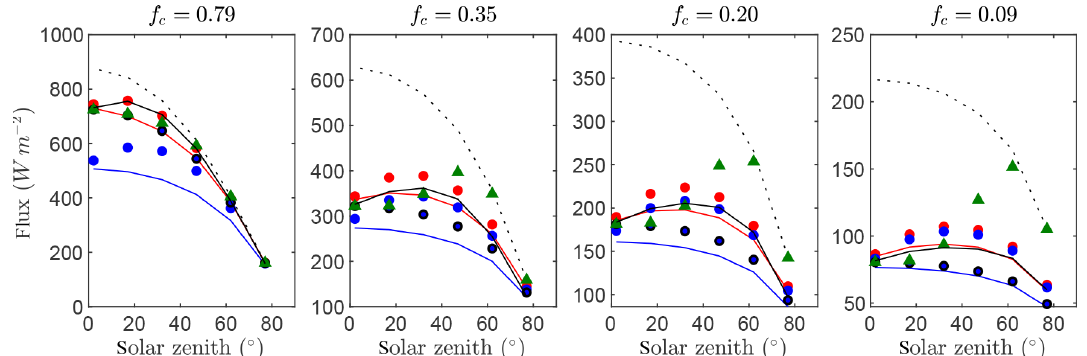
Figure 7. Flux of intercepted radiation versus solar zenith angle for a half-diurnal cycle in a canopy of cylindrical crowns filled with uniformly distributed leaves (see Fig. 3d). Varying ground cover fractions f c were simulated as labeled in each pane. The exact flux is given by the output of the 3-D model (black line), which is compared against the 1-D models BINOM (red line), NIL99_B (red circle), and NIL99_P (blue circle), Ni10_P (blue line) and OM_CON (black circle), OM_VAR (green triangle), and HOM (dotted